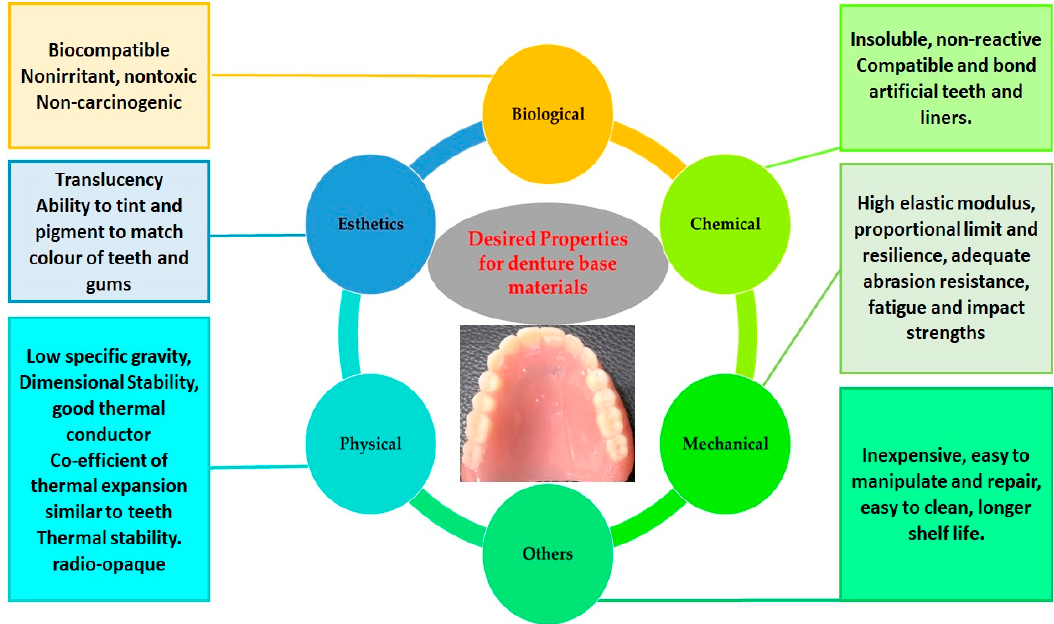
Figure 3. Ideal properties required for the PMMA materials for denture base applications. Table 4. Various properties of heat-cured